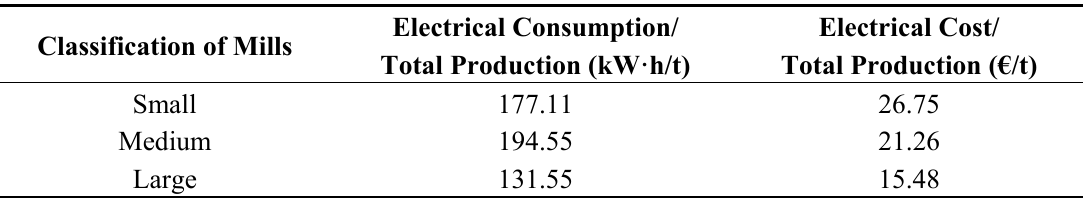
Table 2. Classification of olive mills according to the electrical consumption vs. total production ratio [10] (years 2007–2009).